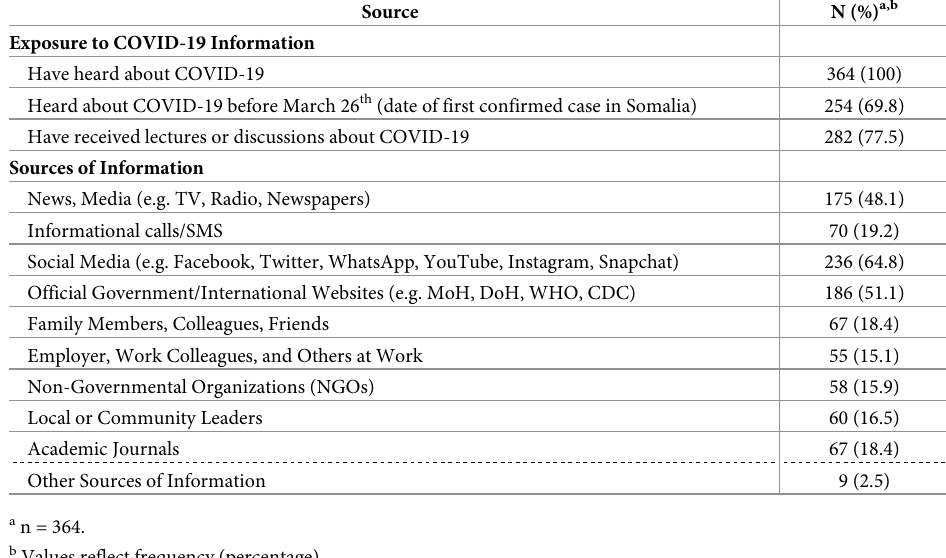
Table 2. Exposure to COVID-19 information and specific sources accessed among Somali healthcare